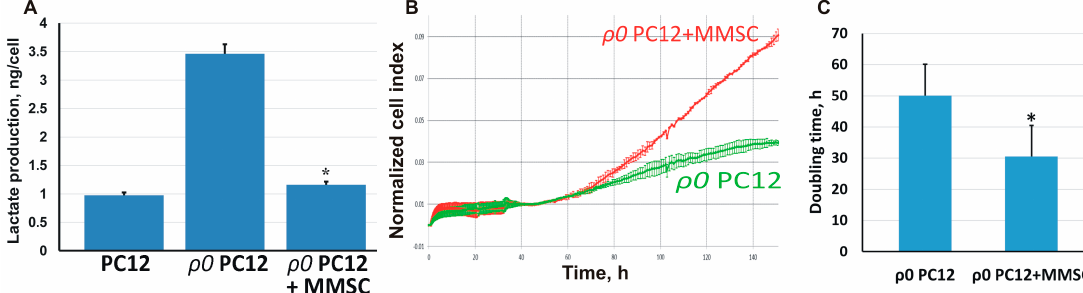
Figure 3. Retardation of glycolysis and higher proliferation in ρ 0 PC12 cells associated with the transfer of mitochondria from MMSC. ( A ) Co-cultivation of MMSC and ρ 0 PC12 cells was associated with lower production of lactate, possibly speeding ATP production from oxidative phosphorylation and blocking glycolysis, thus increasing the normalized cell index ( B ) and reducing the doubling time ( C ), which demonstrated the activation of proliferation in PC12 cells. All experiments were performed at least in triplicate; * denotes significant differences between groups ( p < 0.05) (One-way ANOVA, followed by Tukey’s post hoc analysis). Values are given as mean ± standard error of the mean (SEM).